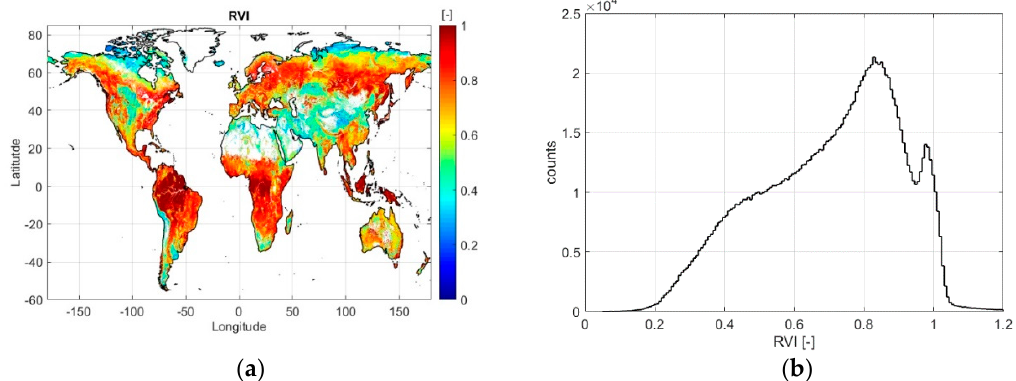
Figure 7. Result of the averaged (April–July 2015) standard RVI [-] calculated with (1): ( a ) global map; ( b ) histogram of values ranging beyond one for high amounts of biomass.